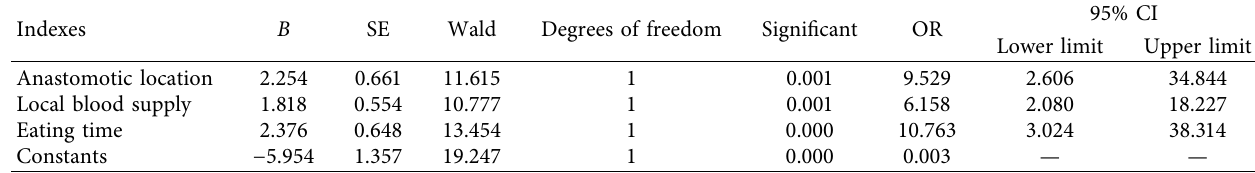
Table 2: Factors leading to postoperative benign anastomotic stricture in patients.